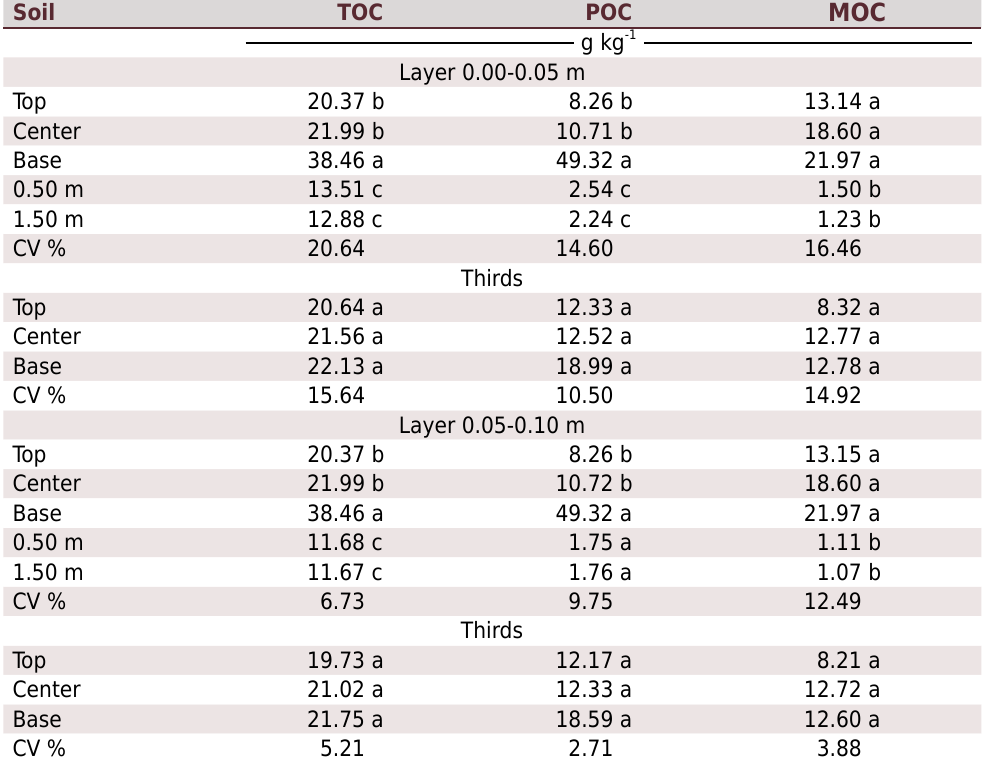
Table 5. Total organic carbon (TOC), particulate organic carbon (POC), and mineral-associated organic carbon (MOC) in termite mounds and surrounding soil, in the 0.00-0.05 and 0.05-0.10 m layers, Mar de Morros region, municipality of Pinheiral, Rio de Janeiro State Soil